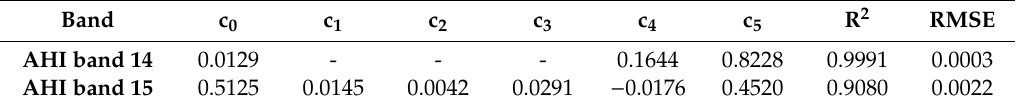
Table 1. Coe ffi cients of the spectral conversion